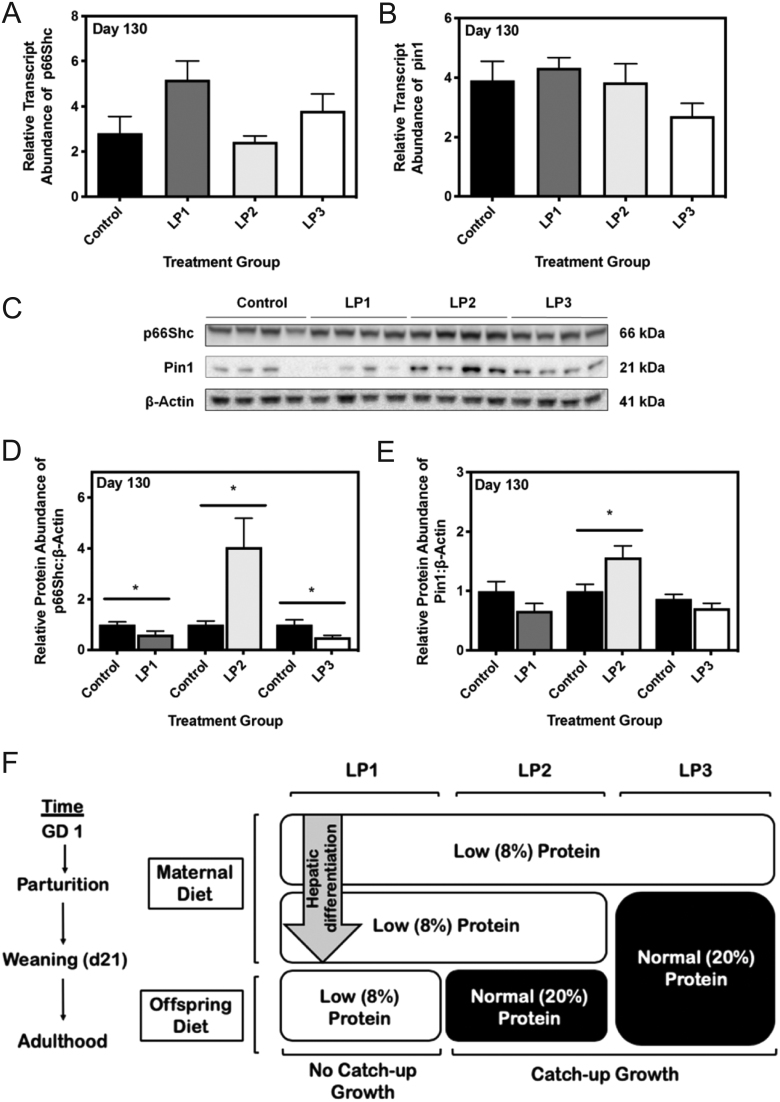
Maternal protein restriction (MPR) and postnatal catch-up growth together increase hepatic p66Shc and PIN1 in 4-month-old male offspring. (A) Percent protein composition and timing of nutritional intervention of each MPR diet. Transcript and protein abundances of p66Shc and Pin1 were determined via quantitative real-time PCR and Western immunoblotting, respectively. Relative transcript abundance of (B) p66Shc and (C) Pin1 were expressed as means normalized to the geometric mean of β-actin and GAPDH ± s.e.m. (n = 7–8/group). (D) Representative western immunoblots for specific targeted protein bands of control, LP1, LP2 and LP3 offspring as detected by primary antibodies for p66Shc and PIN1. Relative protein abundances of (E) p66Shc and (F) PIN1 at 4 months of age were expressed as means normalized to β-Actin ± s.e.m. (n = 7–8/group). All qRT-PCR data were analyzed using a one-way ANOVA and multiple comparisons test, while protein abundances were compared using a two-tailed unpaired Student’s t-test. *Significant difference (P < 0.05).